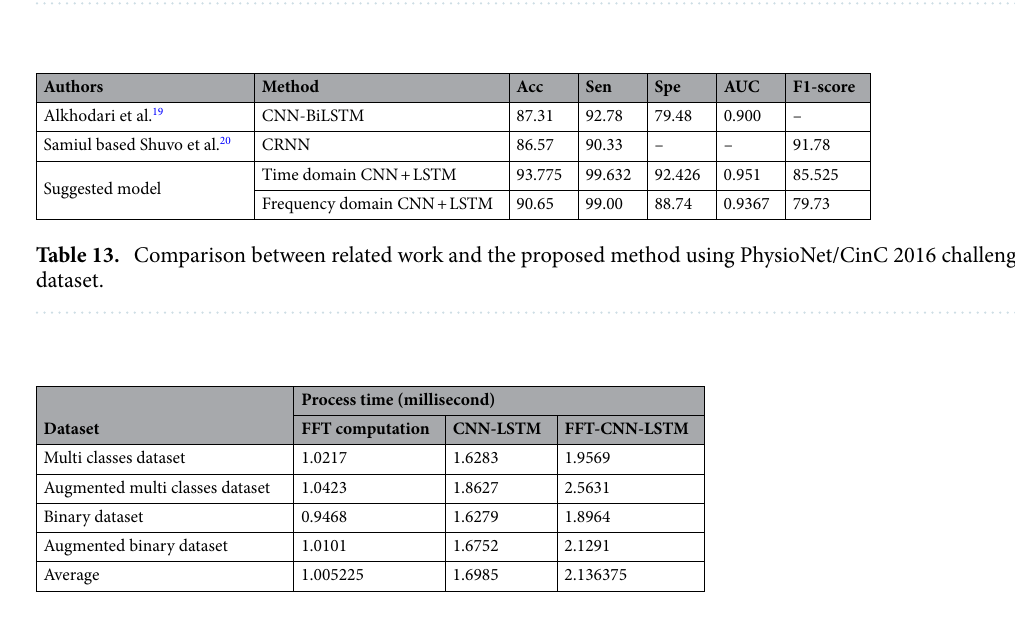
Table 14. Time consumption of the proposed